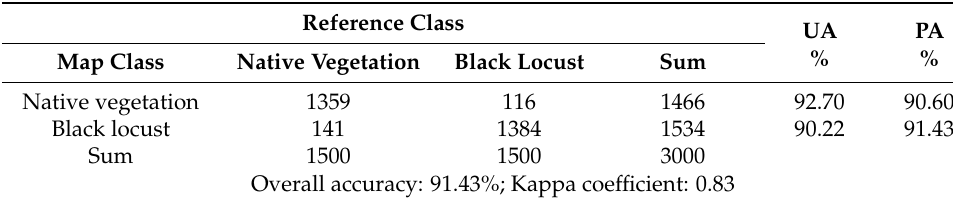
Table 3. Error matrice of the best-case classification of temporally aggregated monthly composites from 2020.